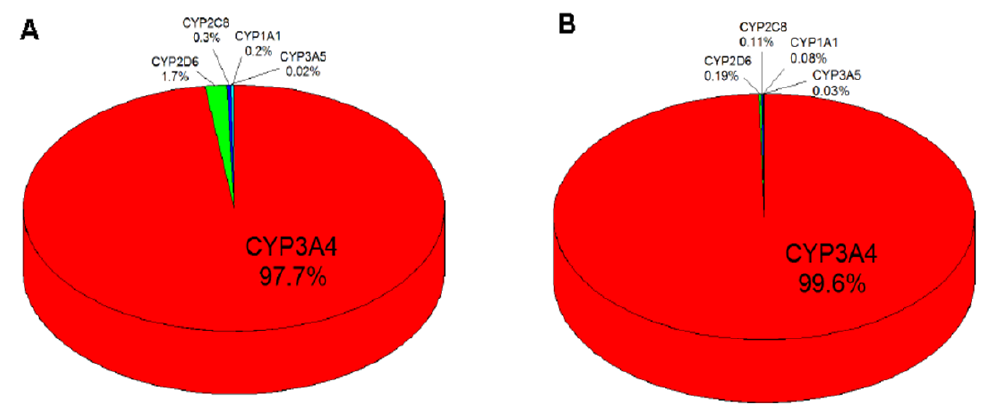
Figure 6. Contributions of human hepatic CYP enzymes to formation of N -desmethylvandetanib without consideration of the effect of cytochrome b 5 ( A ) and with that of cytochrome b 5 ( B ).